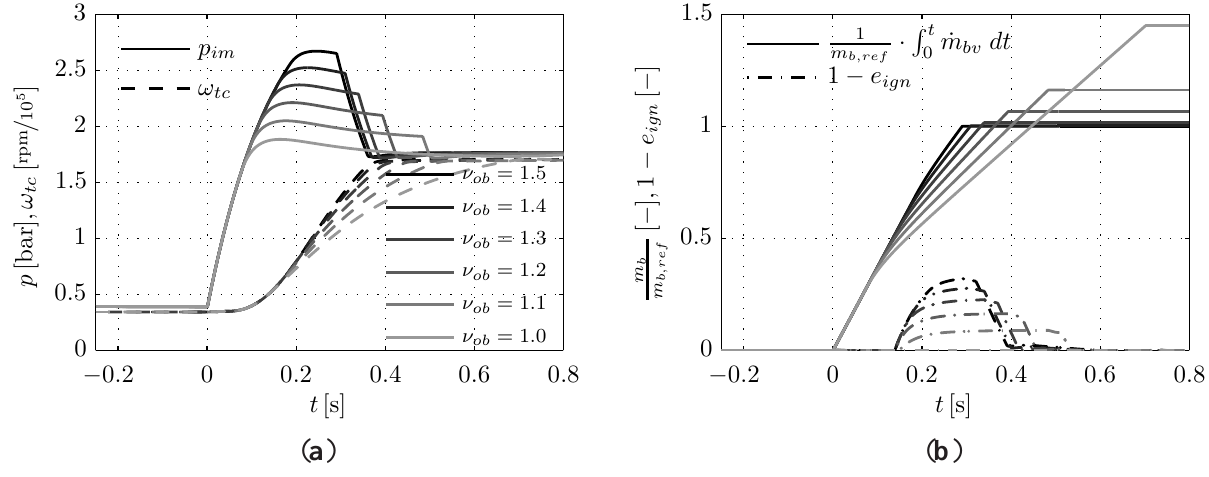
Figure 5. Results for a load step from 1.7 bar to 16.7 bar p using various overboosting factors ν . ( a ) Trajectories of the intake manifold pressure p ob and the turbocharger speed ω ; ( b ) Consumed air mass m tc e efficiency 1 , with m = m ( ν = 1 . 5) . ign b,ref b ob −